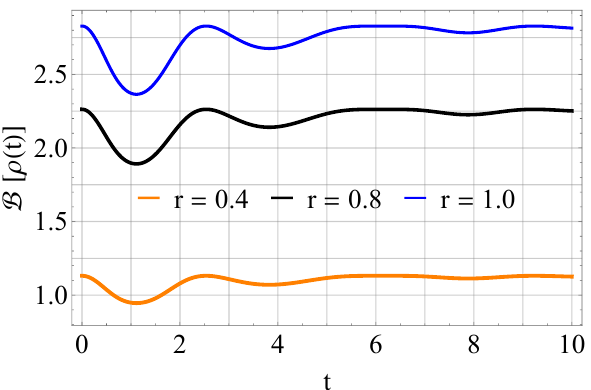
Figure 8. B [ ρ ( t )] for three values of r . The other parameters are ∆ = 0.5, ω = π /6, and b =